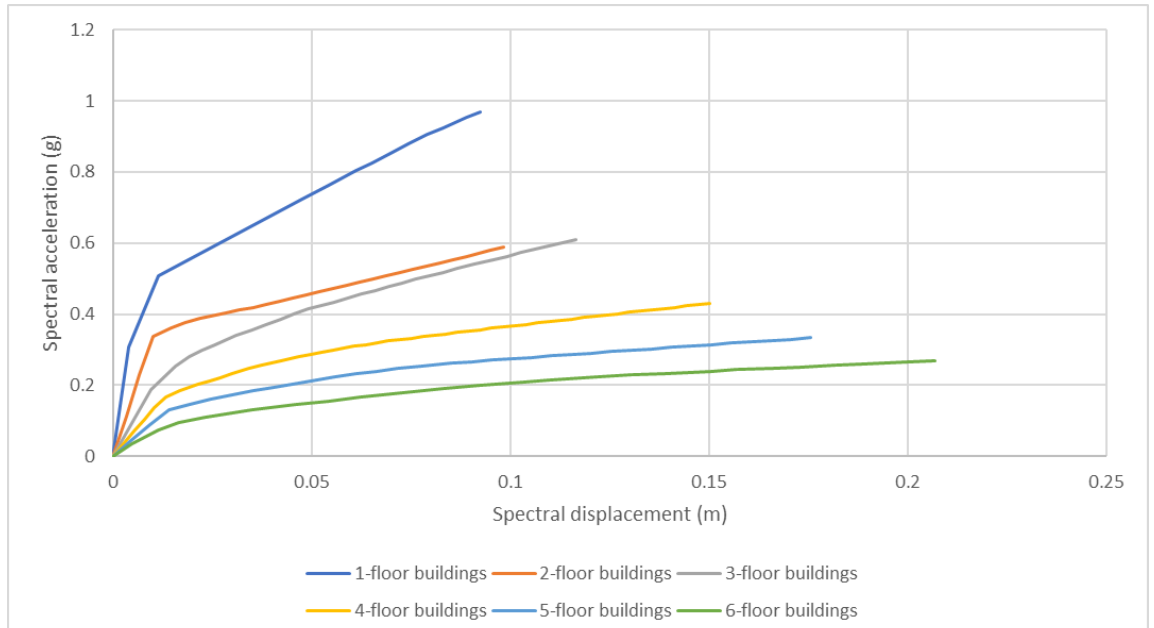
Figure 12. Capacity spectra of buildings with seismic code built after 2002.